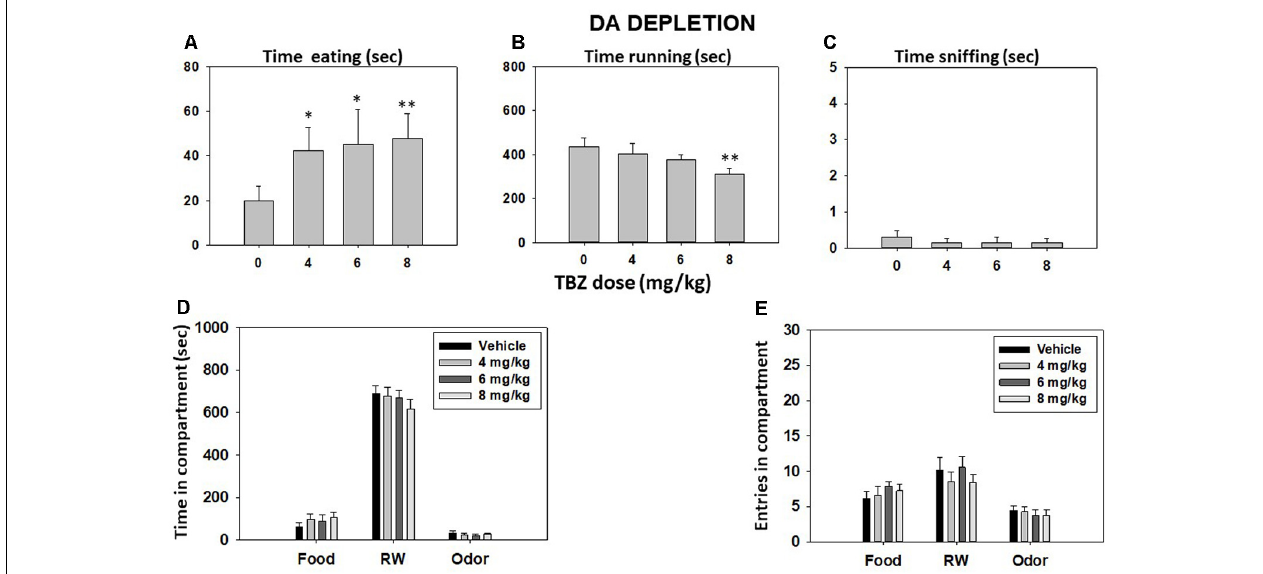
FIGURE 2 | Effect of TBZ (vehicle and 4, 6, and 8 mg/kg) on time eating (A) , time running (B) , time sniffing (C) , time spent in each compartment (D) , and entries into compartments (E) in the T-maze task assessed during 15 min. Bars represent mean ± SEM of accumulated seconds or number of entries. ∗ p < 0.05, ∗∗ p < 0.01 significantly different from the